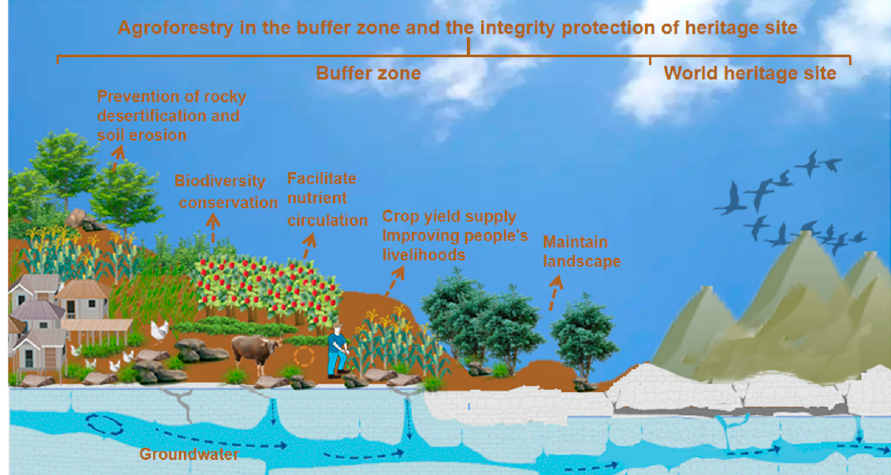
Figure 2. Schematic diagram of the relationship between the integrity protection of NWHS and AF development in the buffer